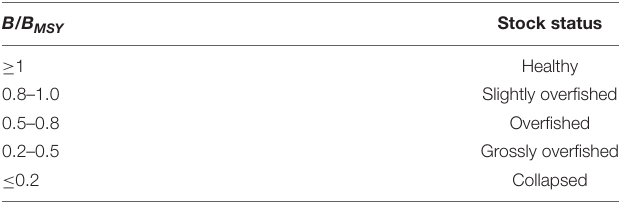
TABLE 2 | The definition of the stock status based on the B/B MSY in the present